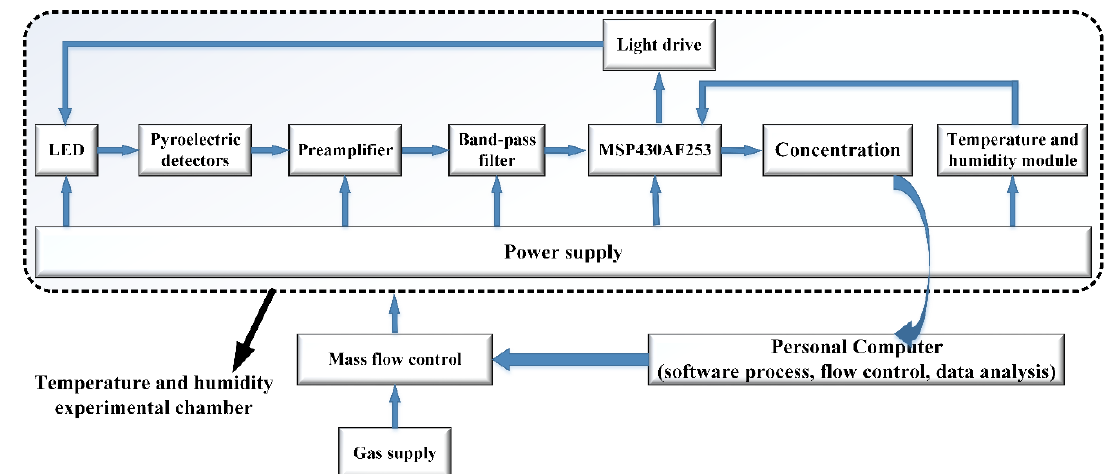
Figure 3. The system framework of the gas sensor module.